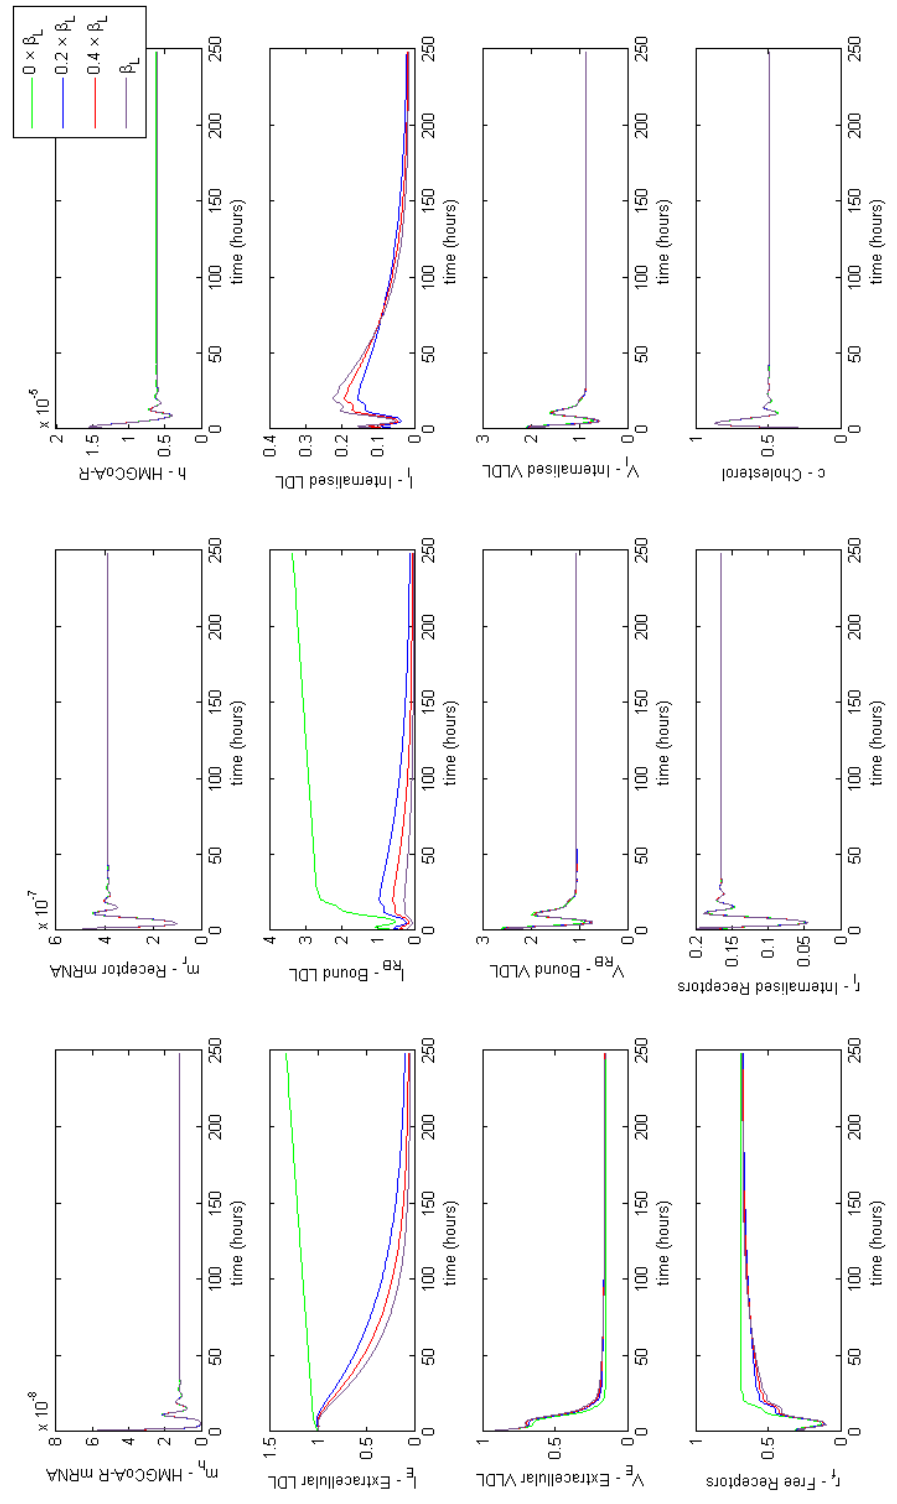
Figure A3. Familial Hypercholesterolaemia Class IV; Bound LDL not internalised properly, affecting parameter β L . Results show the lack of internalisation of bound LDL particles blocking LDL